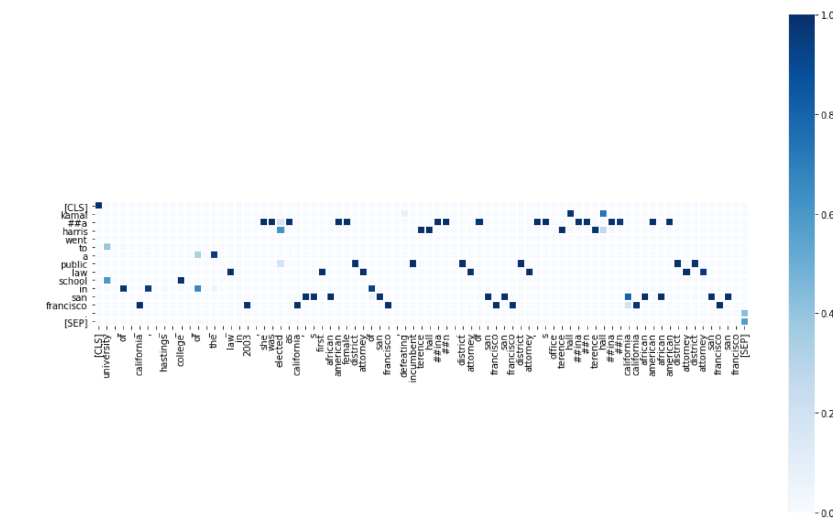
Figure 8. Attention map obtained from the model. Corresponds to Figure 5.